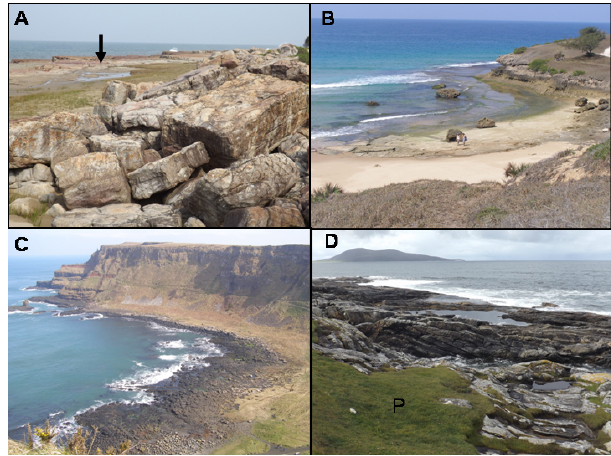
Figure 7. SPS facies association model based around the Cape Mor- gan SPS